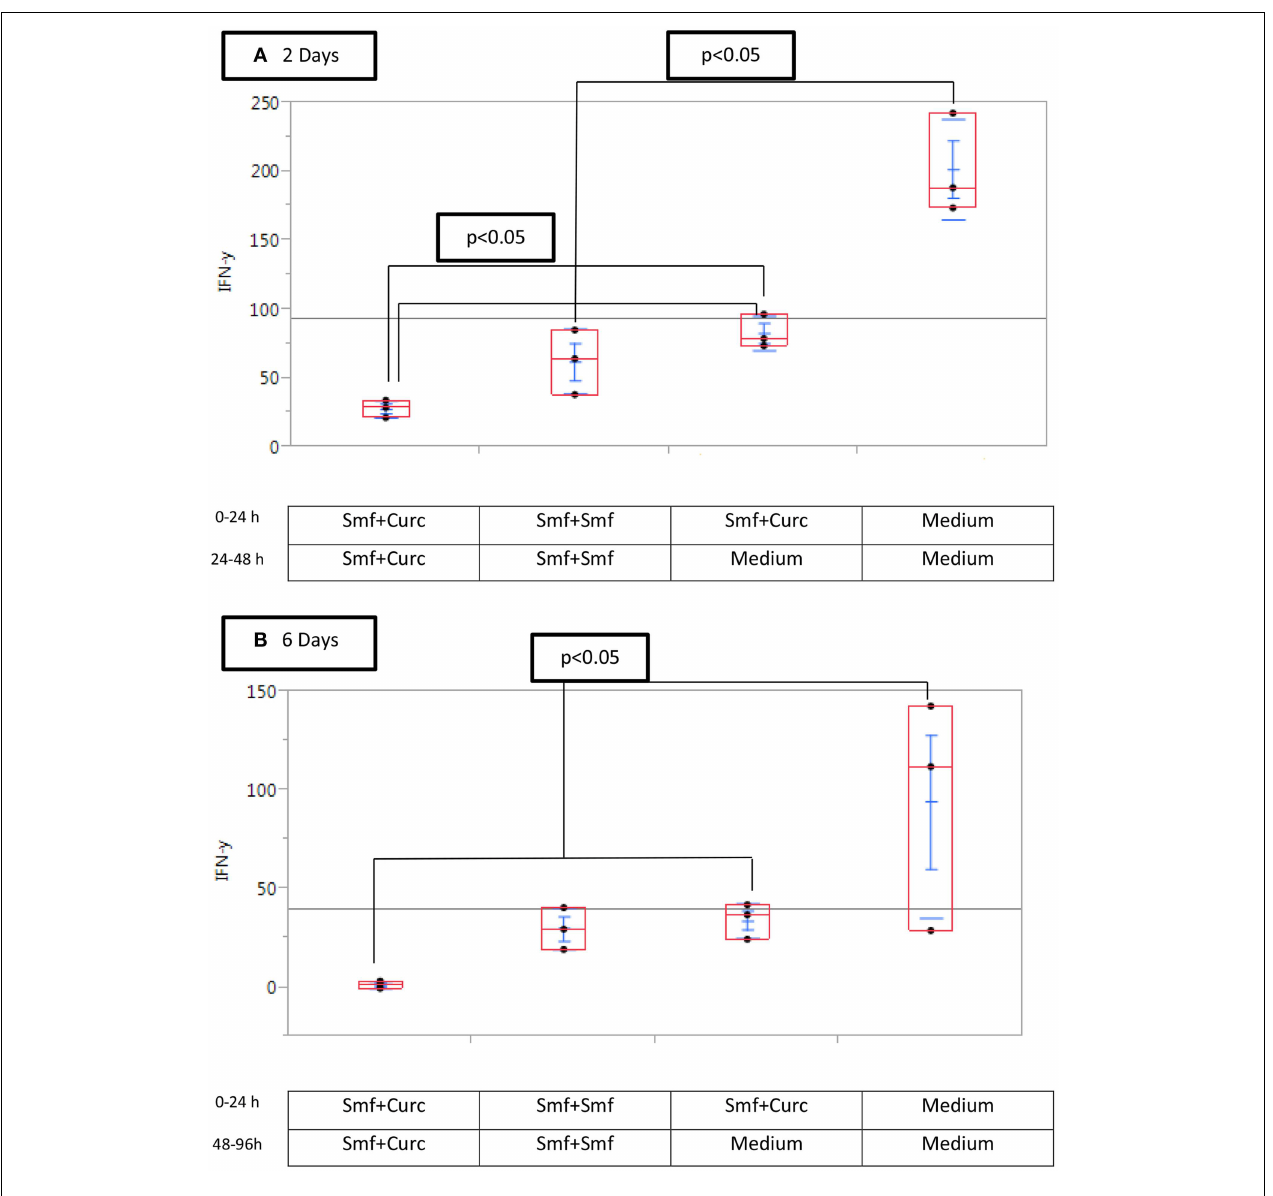
FIGURE 6 | Curcuminoid blockade of interferon- γ production is reduced by removal of curcumin (A) after 2 days, (B) after 6 days. Triplicate MP2 cell cultures in 24-well plates were cultured with or without